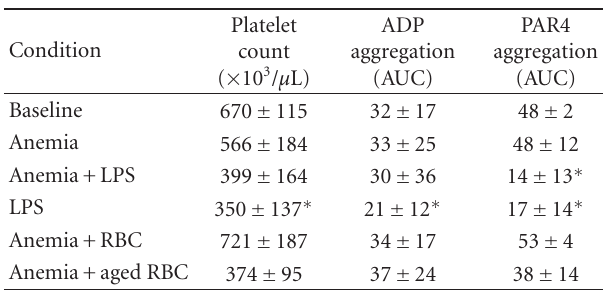
Table 1: Platelet number and function.